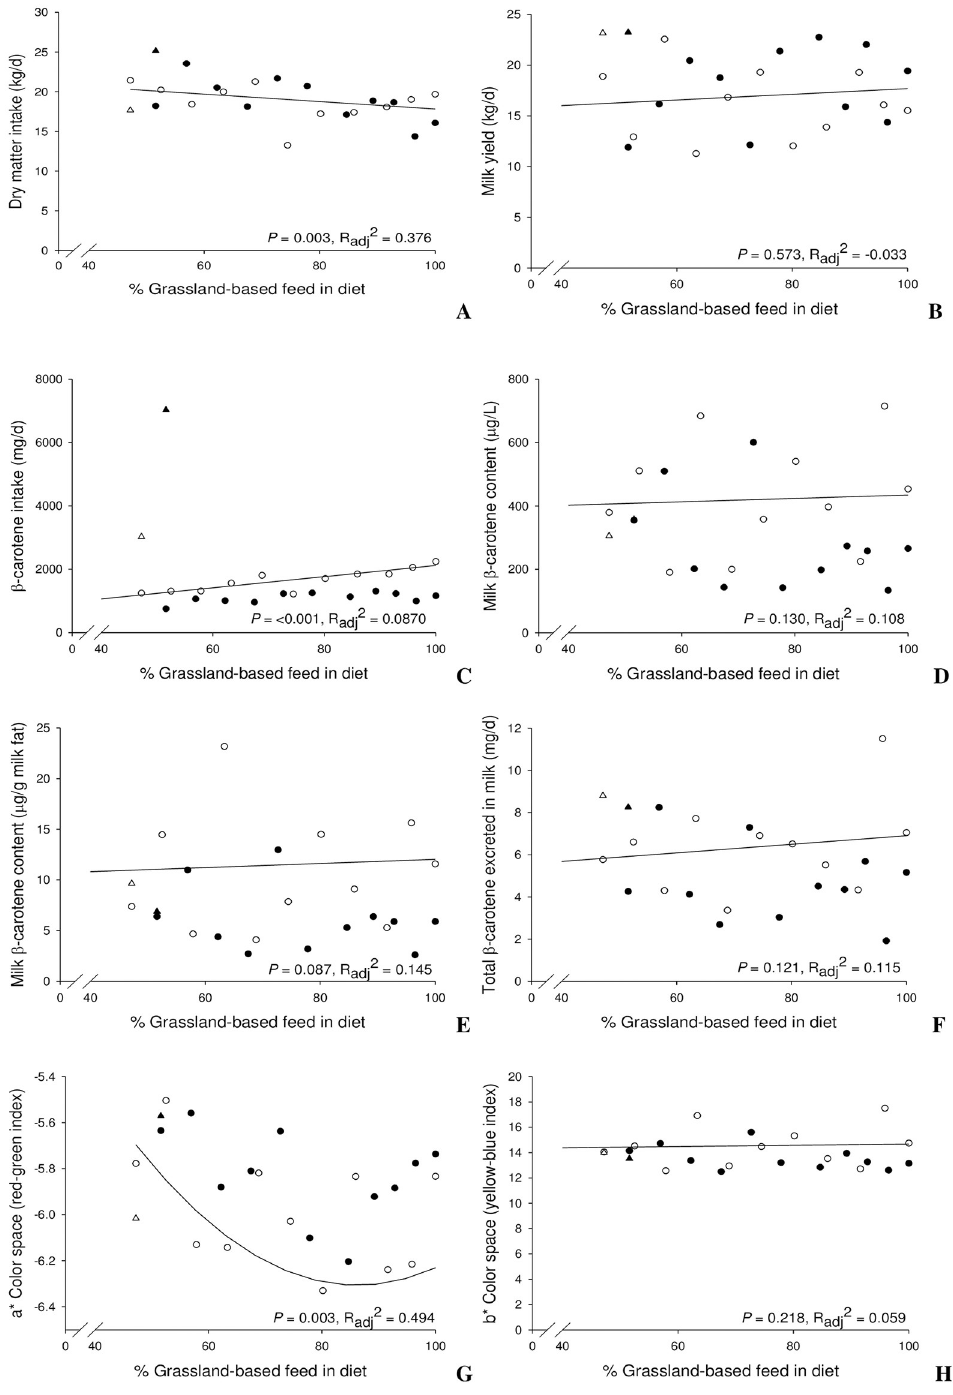
Fig 1. Dry matter intake (A), milk yield (B), β -carotene intake (C), milk β -carotene content in μ g/L (D) and μ g/g milk fat (E), total daily excretion of β -carotene in milk (F), milk a � color space (G), and milk b � color space (H), in relation to the percentage of grassland-based feed in the dairy cow’s diet. Cows supplemented with β -carotene are depicted as triangles and were excluded from the regressions. Harvest years are presented separately (2018 as filled data points; 2019 as hollow data points). The slope of the regression, P -values ( P ) and adjusted R-squared (R adj2 ) represent the regression model across all data (for details of regression models see Table 2 and S3 Table.